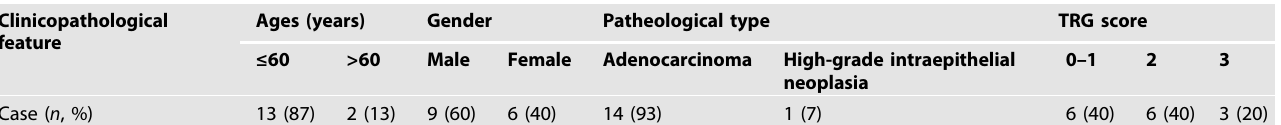
Table 2. Clinicopathological features of CRC patients ( n =